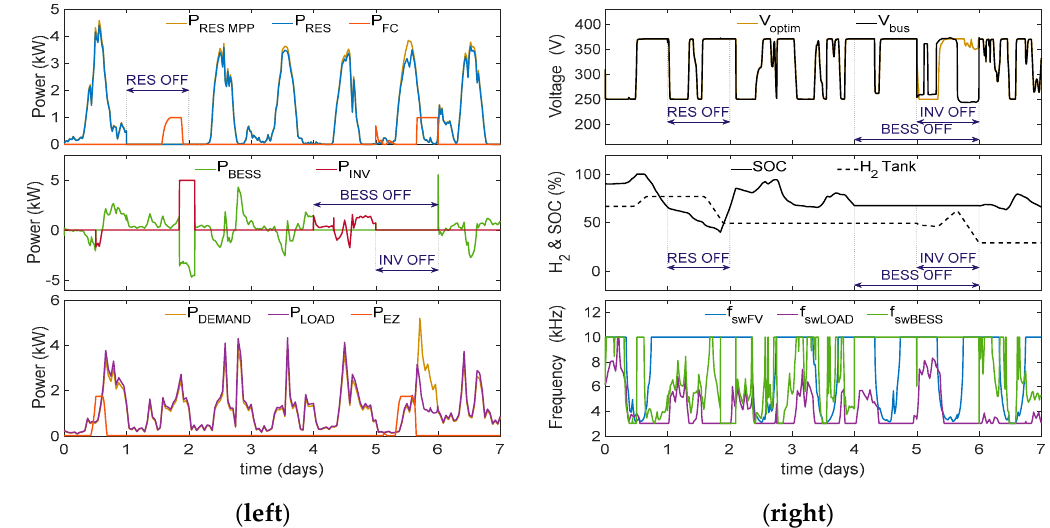
( right ) Figure 7. MG simulation over 7 days with the optimized control system: E-BCS + BVOC BESS + OOSF. From top to bottom, the graphs in the left column represent: (1) Sources power: available RES power, actual RES power injected in the DC bus, and FC power injected in the DC bus; (2) BESS and INV power; (3) Loads power: critical loads electricity demand, actual LOAD power consumed from the DC bus, and EZ power consumed from the DC bus. The graphs in the right column represent: (1) Optimum bus voltage reference and actual bus voltage evolution; (2) SOC and hydrogen tank level evolution; (3) Optimized switching frequencies of three converters: PV, LOAD and BESS.